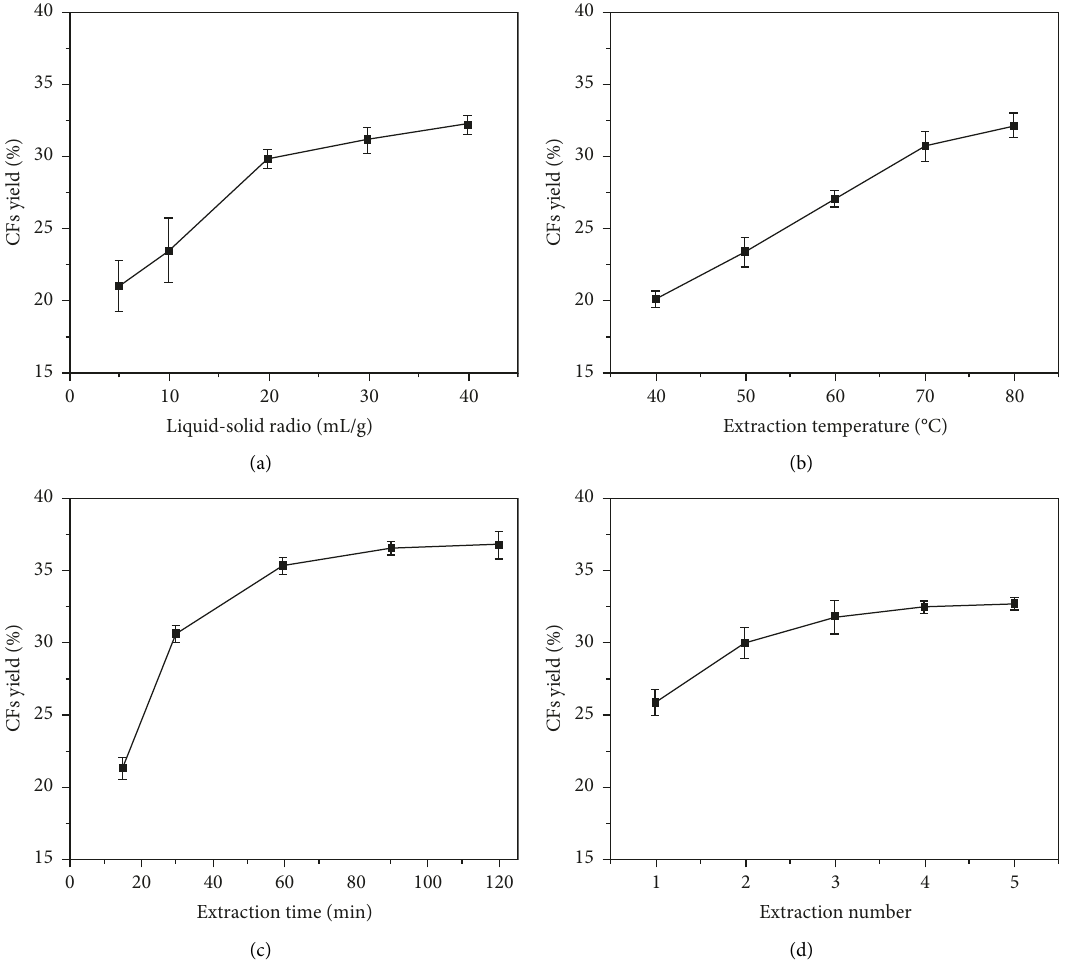
Figure 1: Effects of different extraction parameters on the yield of CFs: liquid-solid ratio (a), extraction temperature (b), extraction duration (c), and number of extractions